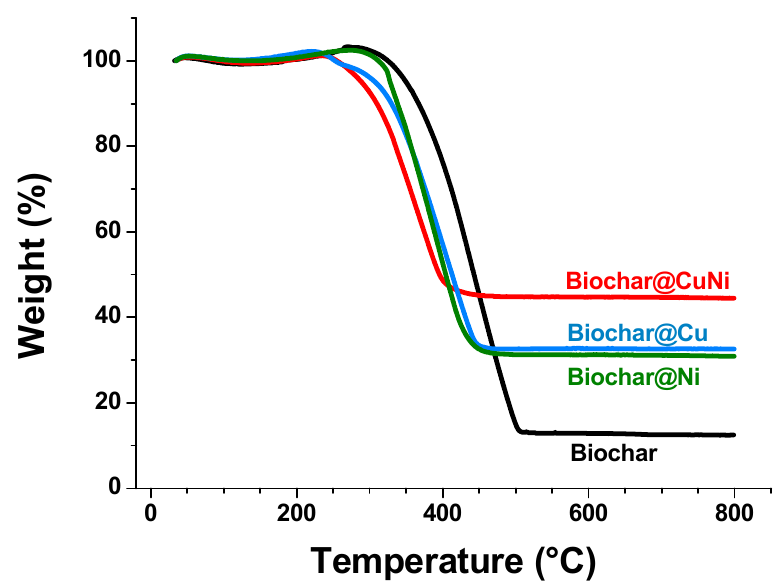
Figure 7. TGA plots recorded under air for biochar and B@CuNi.